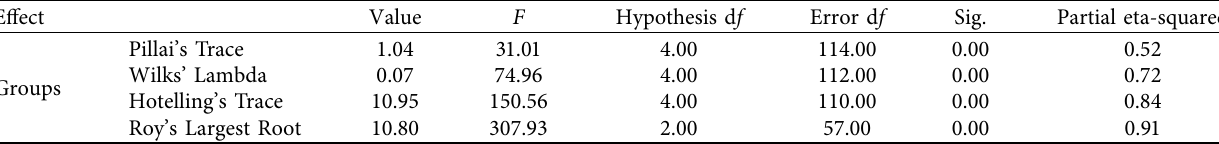
Table 6: MANOVA results for the learners’ writing and speaking gain scores.